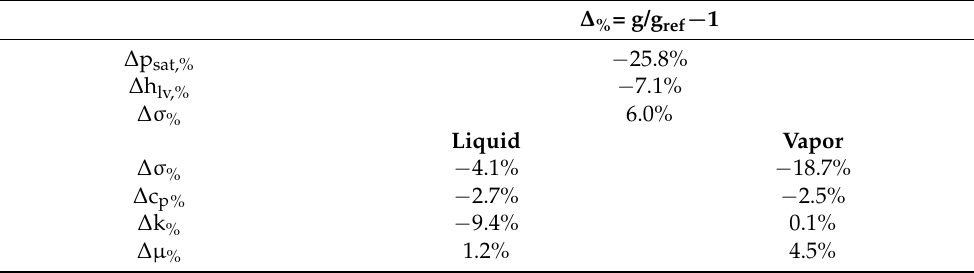
Table 4. Thermal properties percentage variation.